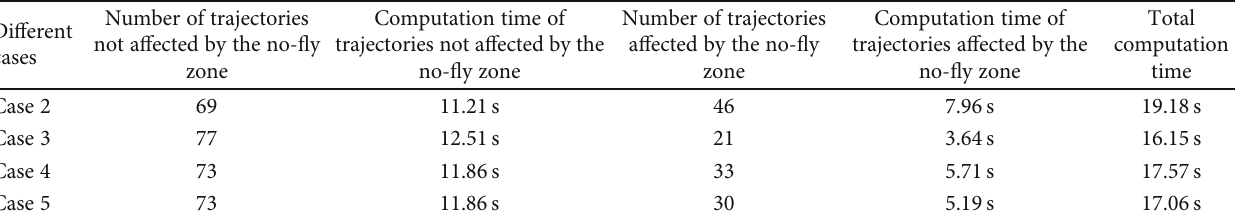
Table 3: Computation times of di ff erent